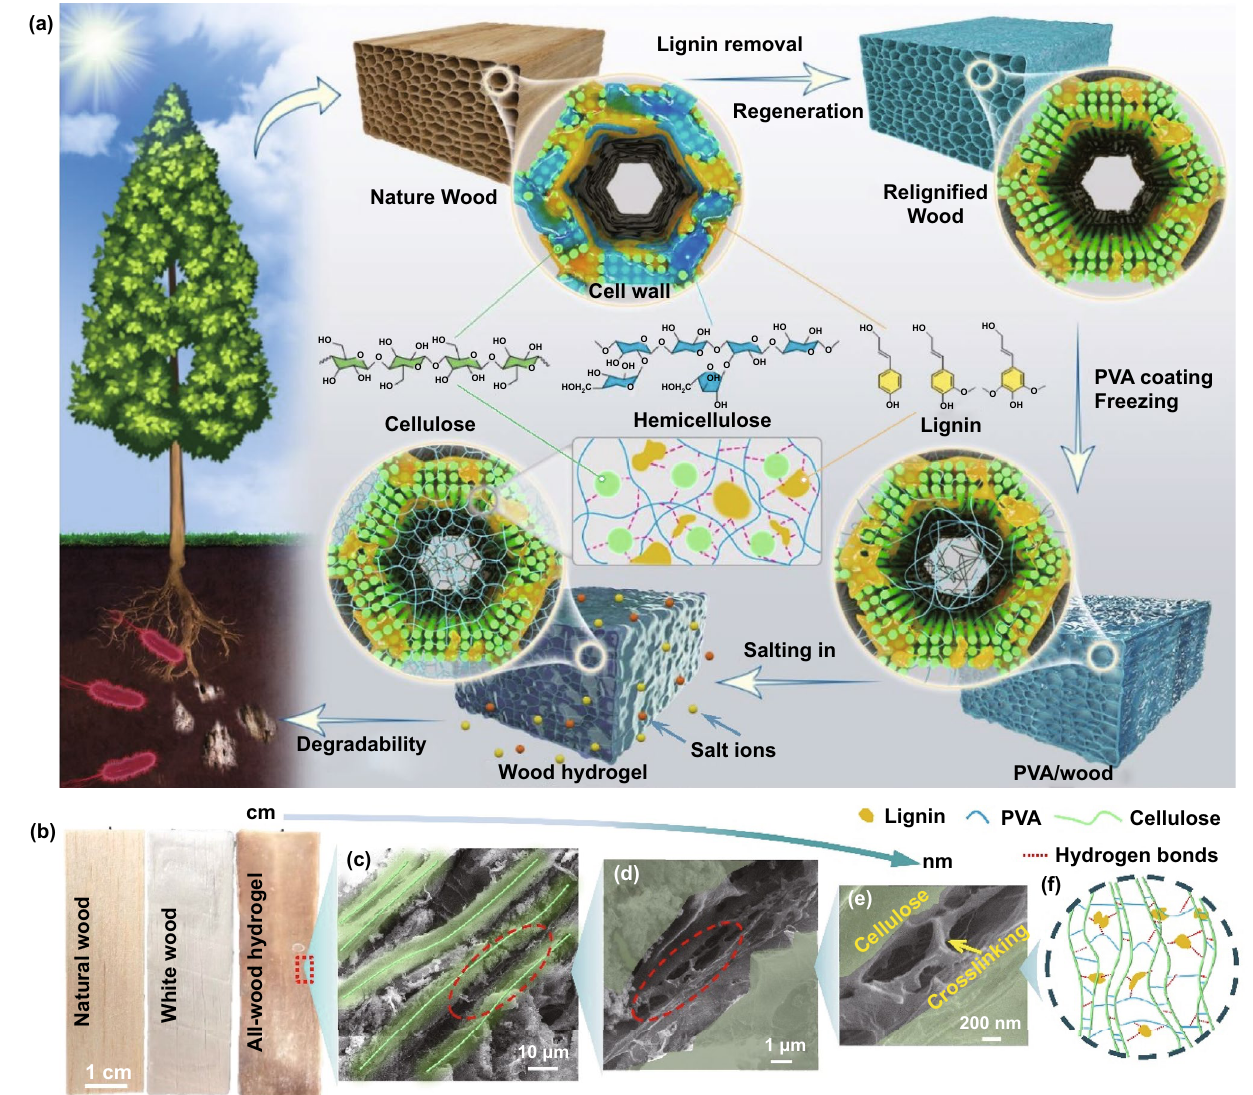
Fig. 1 Fabrication process of the PVA-reinforced all-wood hydrogel. a The preparation process of the hydrogels via the Hofmeister effect includes the delignification, relignification, PVA soak process, freezing, and salt-assisted aggregation. b Digital images of natural wood, white wood, and all-wood hydrogel. c–e SEM images showing the hierarchical structure of the all-wood hydrogel. f Schematic diagram of the chemi- cal cross-linking of cellulose fibers, lignin molecules, and PVA molecular